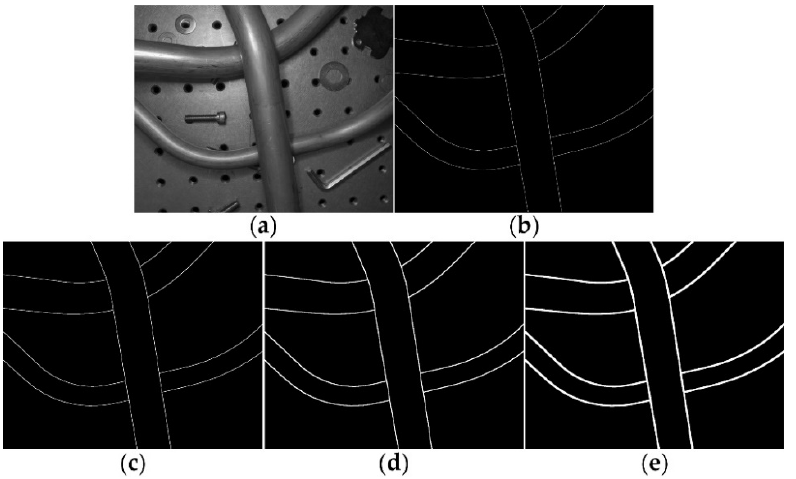
Figure 6. The tone mapped HDR image and the corresponding tube contour labels with different widths. ( a ) Tone mapped HDR image; ( b ) 1-pixel contour width; ( c ) 2-pixel contour width; ( d ) 4-pixel contour width; and ( e ) 8-pixel contour width.